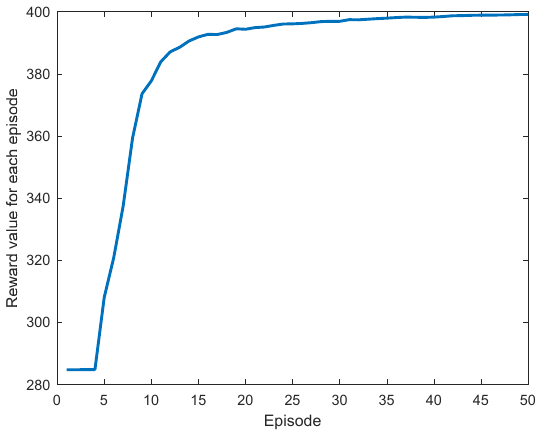
Figure 5. Reward value for each episode by DDPGPIR agent.